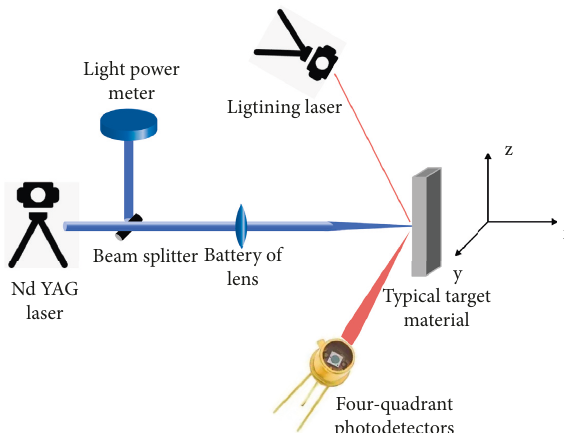
Figure 2: Schematic diagram of the overall system structure